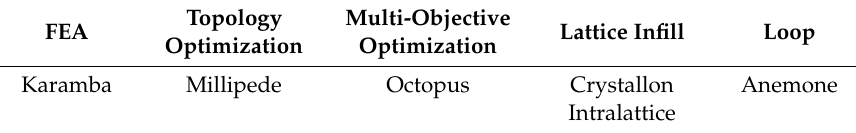
Table 2. Selected plug-ins applied in the proposed methodology.